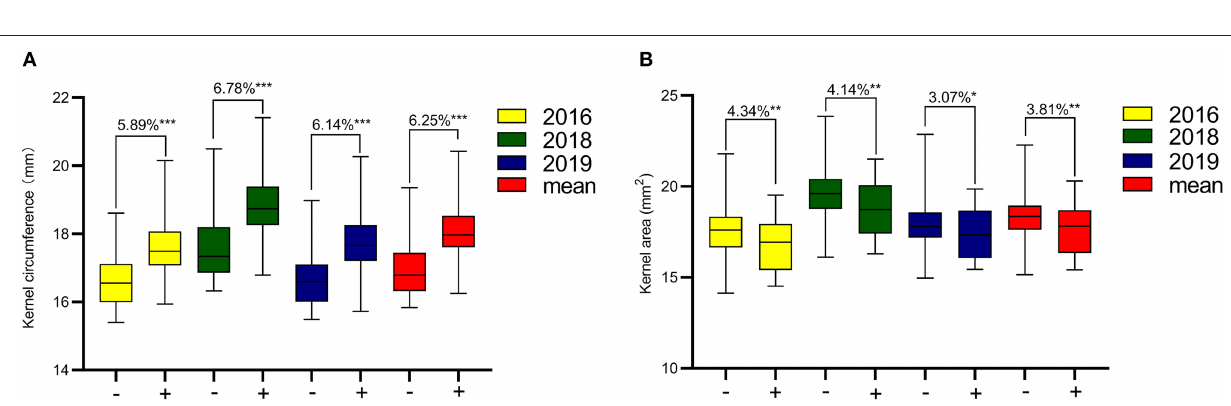
in Chinese Spring and T. Turgidum ssp . dicoccoides,